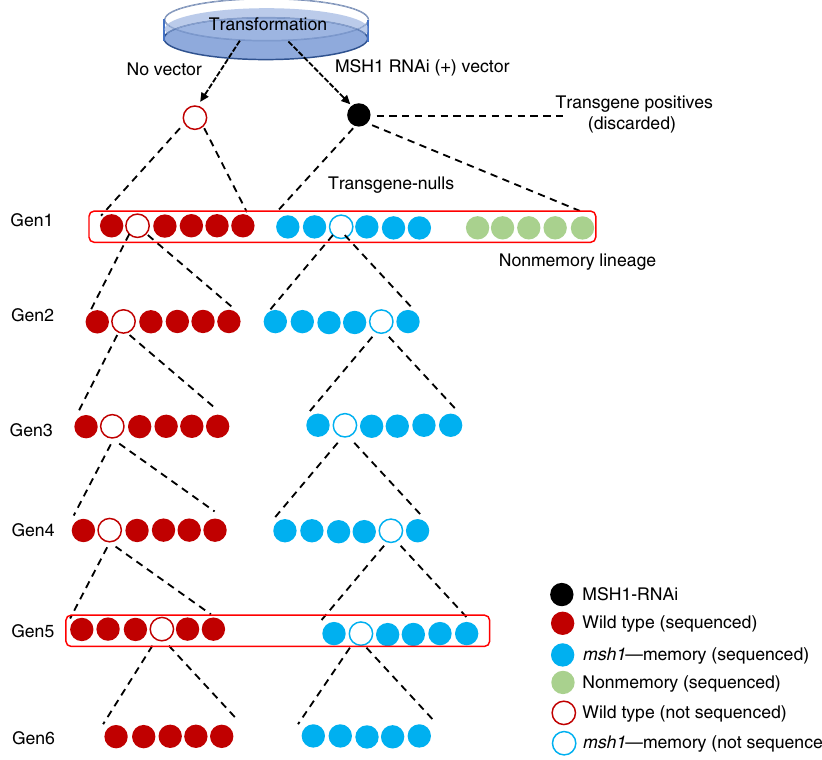
Fig. 2 Transgenerational msh1 memory line pedigree and sample collection strategy. The msh1 memory lineage was developed by selecting transgene- null progeny from segregation of the MSH1 -RNAi transgene, maintained through six generations in parallel to a wild-type control (through same transformation procedure) for each generation. Five plants from each generation (represented as solid circles) were processed for bisul fi te sequencing, and fi ve plants from wild type (WT), msh1 memory (MM) and nonmemory (NM) generation 1 and WT and MM generation 5 were processed for RNAseq at the same time (red outline). Rosette leaf tissues were collected at bolting